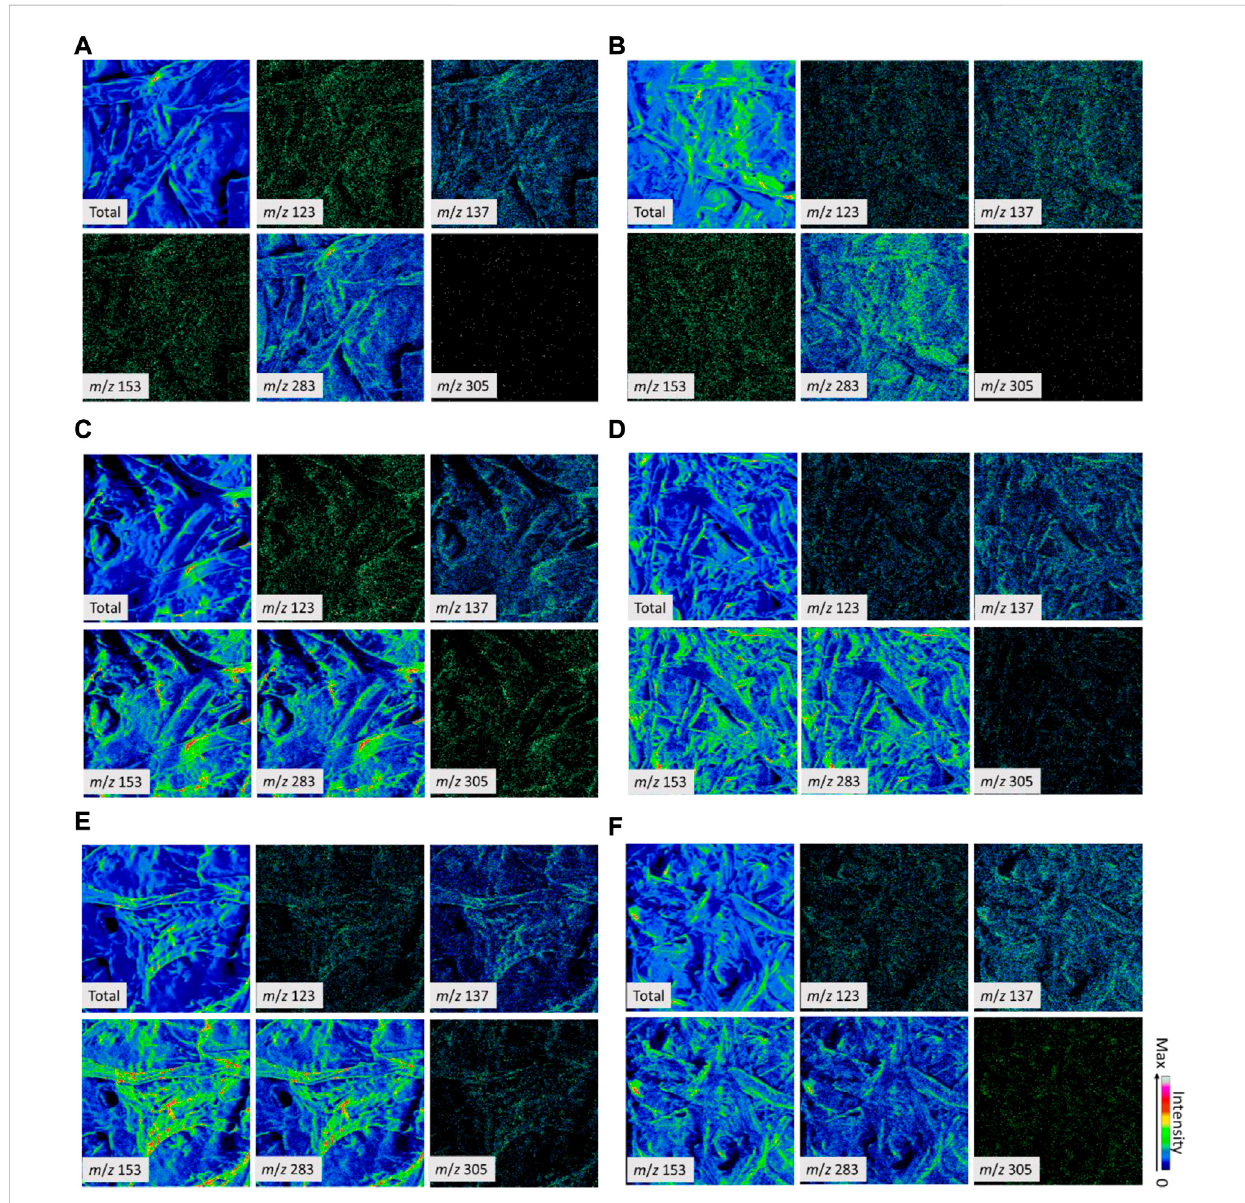
Positive ToF-SIMS images of the non-treated and tannic acid (TA)-treated paper samples of 60 g/m 2 (A, C, E) and 130 g/m 2 (B, D, F) . The peaks generated from tannic acid ( m / z of 153 and 305),the surface of handsheets ( m / z of 137 and 283), and a candidate peak from tannin-richbark extract that was not present in the samples ( m / z 123). Total secondary ions (Total) represent the surface structures of fi ber matrices. (A, B) : blank; (C, D) , 2% TA; and E-F, 4% TA. The color scale was adjusted to 0 – 255 (8 bit) (bottom, zero; top,